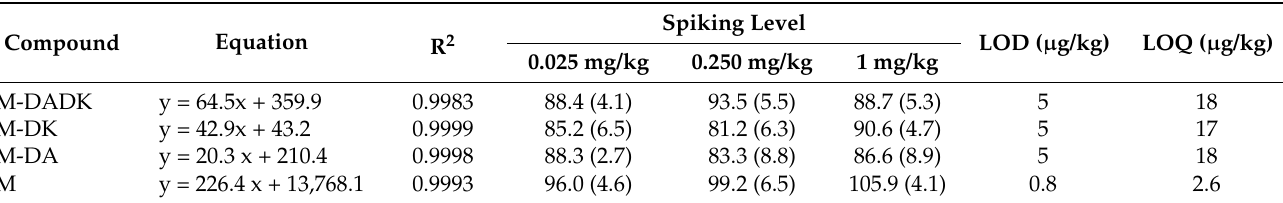
Table 4. Calibration equations, R 2 values, recoveries, and relative standard deviation (%, n = 3), quantification limits (LOQs), and detection limits (LODs) of metribuzin and its metabolites in bean plant